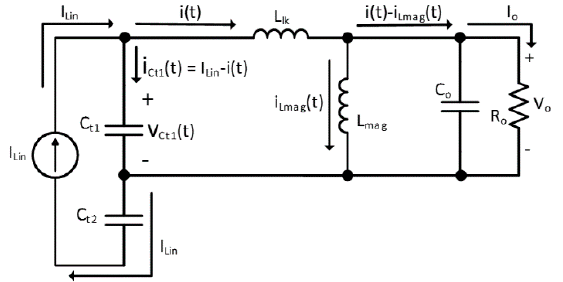
Figure 5. T on equivalent circuit. V o , C o, and R o are the output voltage and the values of the components present in the secondary side of the transformer reflected to the primary side, respectively.